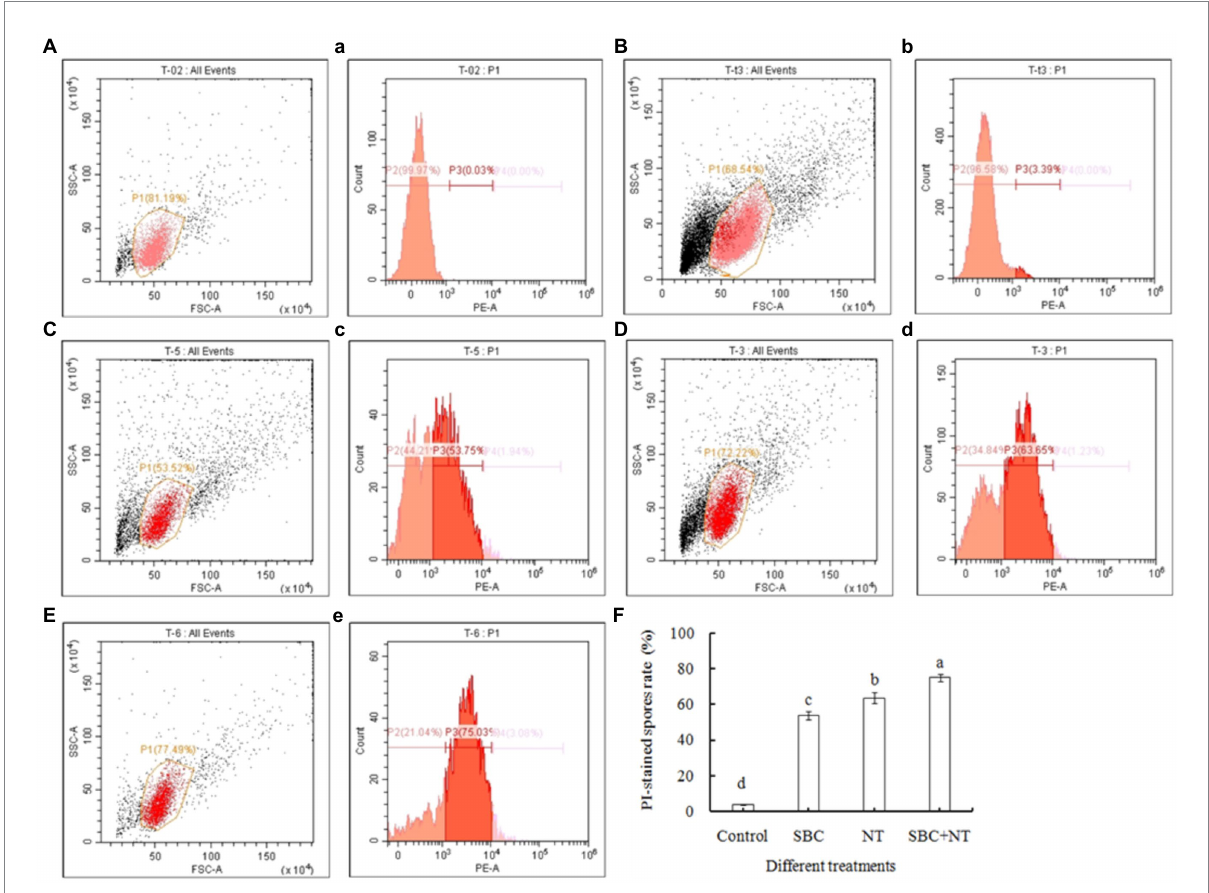
FIGURE 9 Flow cytometry analysis of the plasma membrane integrity of Aspergillus niger spores treated with SBC or NT. (A–E) Scattergram showing cell complexity (side scatter, SSC) vs. cell size (forward scatter, FSC); (a–e) the corresponding percentage of PI-stained spores compared with the control. (A,a) Autofluorescence of non-treated cells; (B,b) fluorescence of non-treated cells for PI staining; (C–E) cells treated with the varying treatments of SBC (c) , NT (d) , and SBC + NT (e) ; (F) the percentage of PI-stained spores rate after different treatments. ANOVA was employed to compare the mean values of analysis parameters ( p < 0.05). The results are shown as the mean ± standard deviation ( n = 3). Different superscript letters in the same column indicate significant differences ( p <